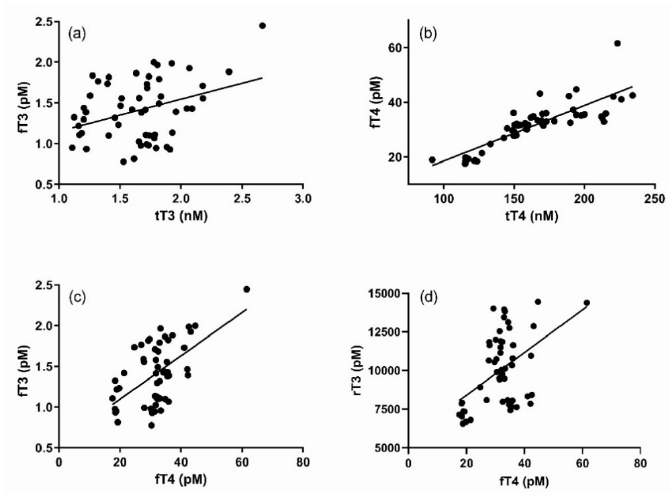
Figure 3. Plots of significant direct relationships between ( a ) fT3 and tT3 ( p < 0.01, r 2 = 0.12), ( b ) fT4 and tT4 ( p < 0.001, r 2 = 0.69), ( c ) fT3 and fT4 ( p < 0.001, r 2 = 0.32), and ( d ) rT3 and fT4 ( p < 0.001, r 2 = 0.23).